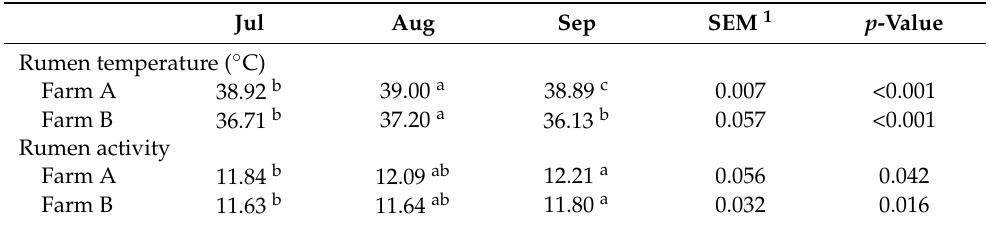
Table 5. Rumen temperature and activity of lactating Holstein cows using rumen sensors at different farms from July to September.